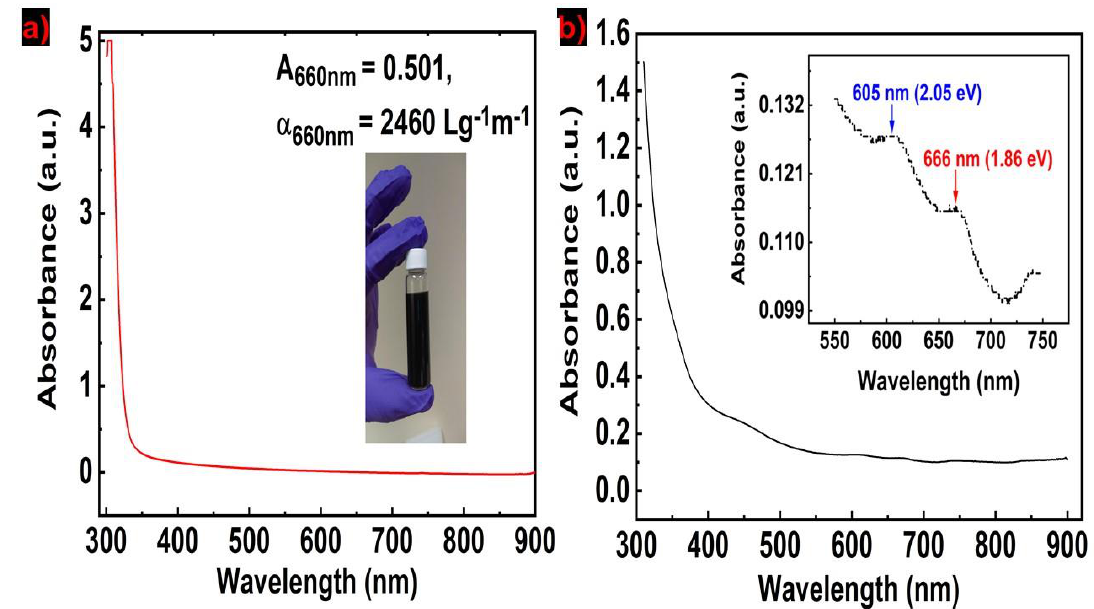
Figure 3. ( a ) Optical absorption of NDG ink shown in the inset; ( b ) absorbance spectra of MoS 2 ink (inset: peak positions in MoS 2 ink). (inset: peak positions in MoS 2